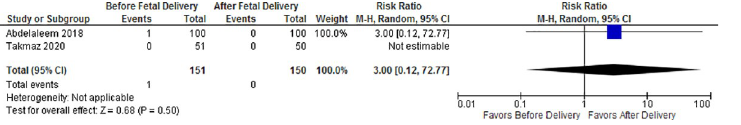
Fig 6. Forest plot of comparison: Pre-fetal extraction versus post-fetal extraction. Outcome: incidence of hysterectomy.